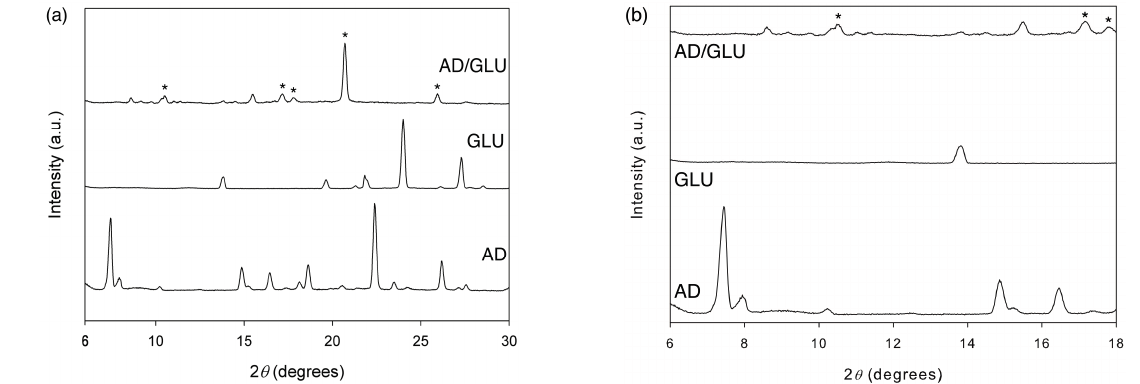
Figure 3. X-ray diffraction (XRD) patterns of the AD/GLU cocrystal and its raw materials (AD and GLU): 2 θ regions of 6°–30° ( a ) and 6°–18° ( b ). Some characteristic peaks of the AD/GLU cocrystal were marked by asterisks.